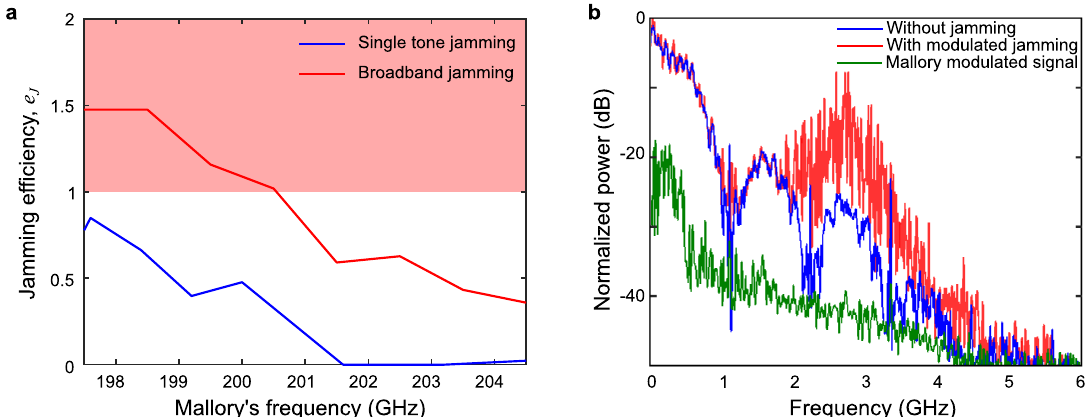
Fig. 6 Modulated jamming. a Sweeping Mallory ’ s frequency from 197.5 to 205 GHz for the single-tone jammer (red line) and the modulated jammer (blue line), shows a difference in the jamming ef fi ciency. The modulated jammer achieves jamming ef fi ciency of 1 and completely destroy the signal (red region). b Bob ’ s received spectrum when jammed (red) shows an interference signal due to Mallory ’ s jamming attack with a modulated data (green), compared to Alice ’ s original signal (blue). Here, Mallory ’ s center frequency is at 200